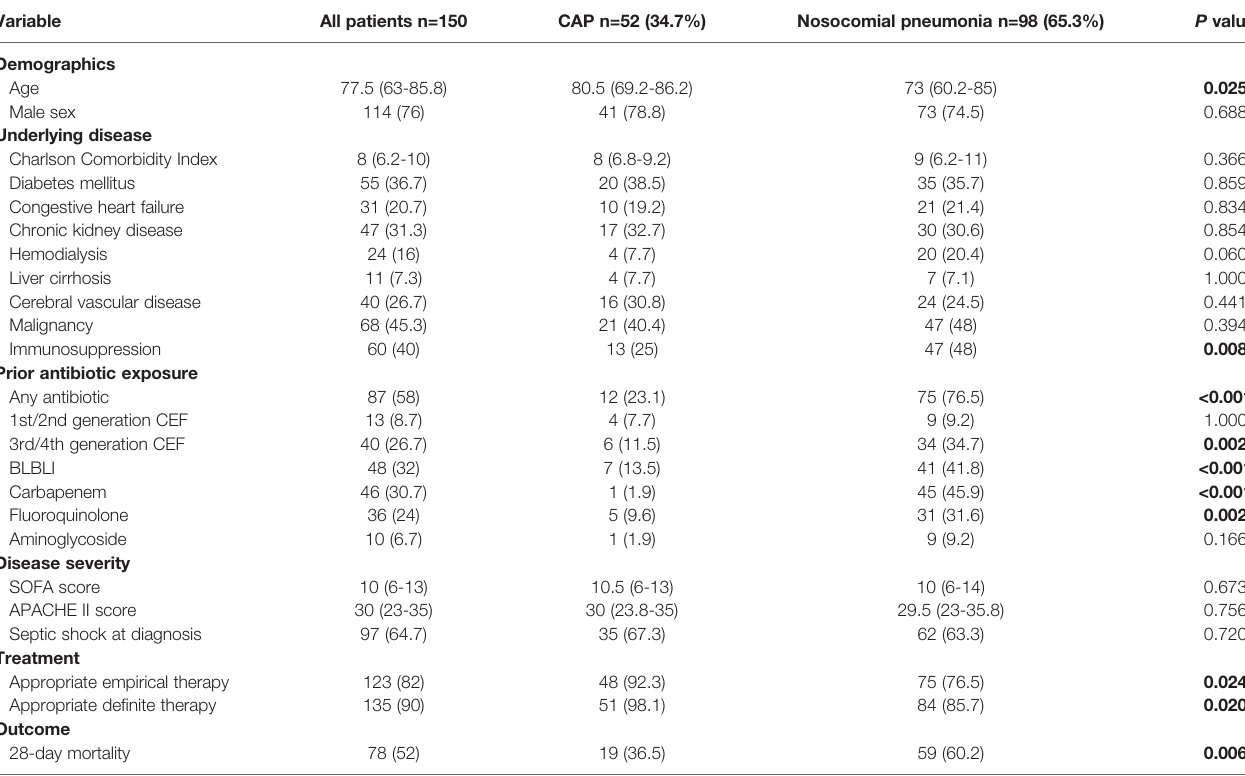
TABLE 1 | Clinical characteristics of patients with K. pneumoniae bacteremic pneumonia. Variable All patients